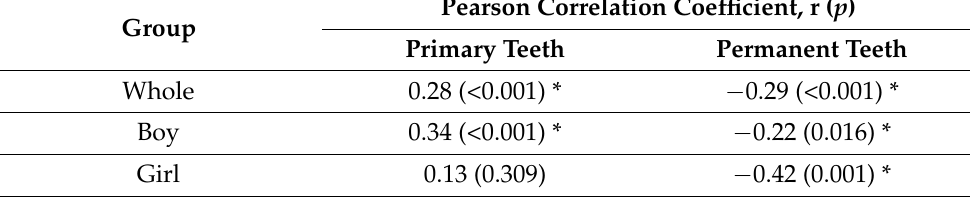
Table 4. Correlations between primary and permanent tooth width and leeway space for all children and boy and girl